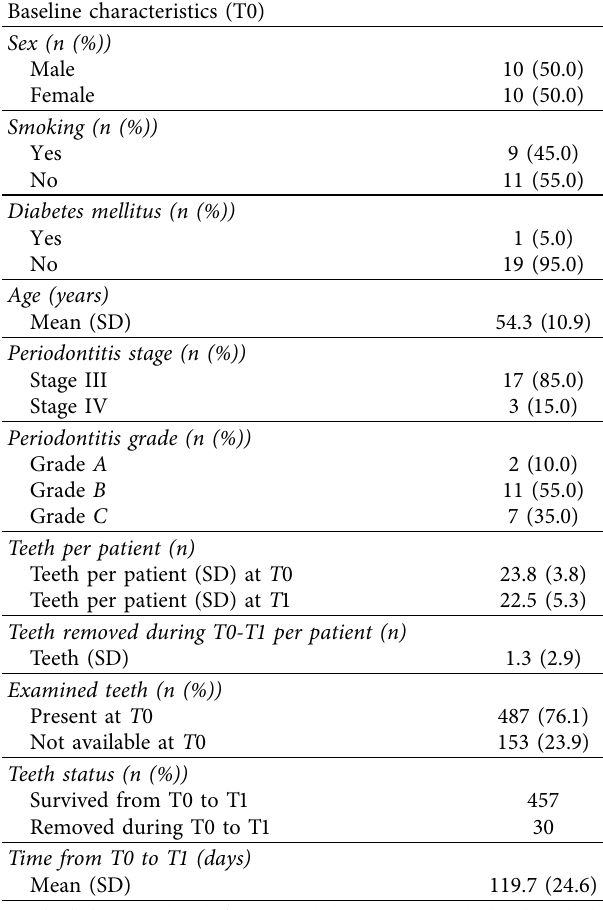
Table 1: Demographic and clinical data of the patient